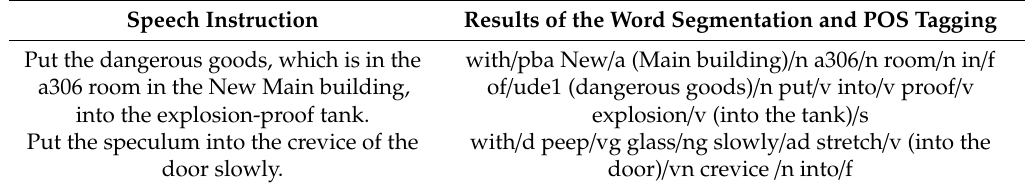
Table 4. Results of the word segmentation and POS (part-of-speech) tagging of Chinese instructions. Speech Instruction Results of the Word Segmentation and POS